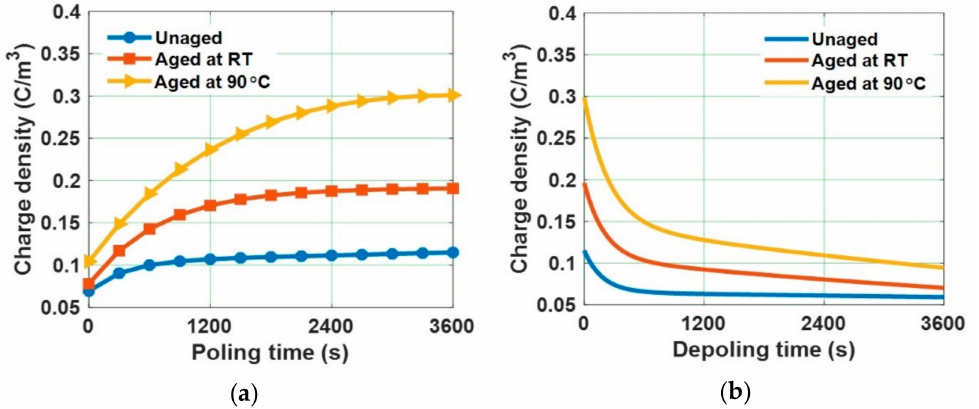
Figure 16. Mean value of absolute space charge density in water aged samples during ( a ) poling time and ( b ) depoling time [30].